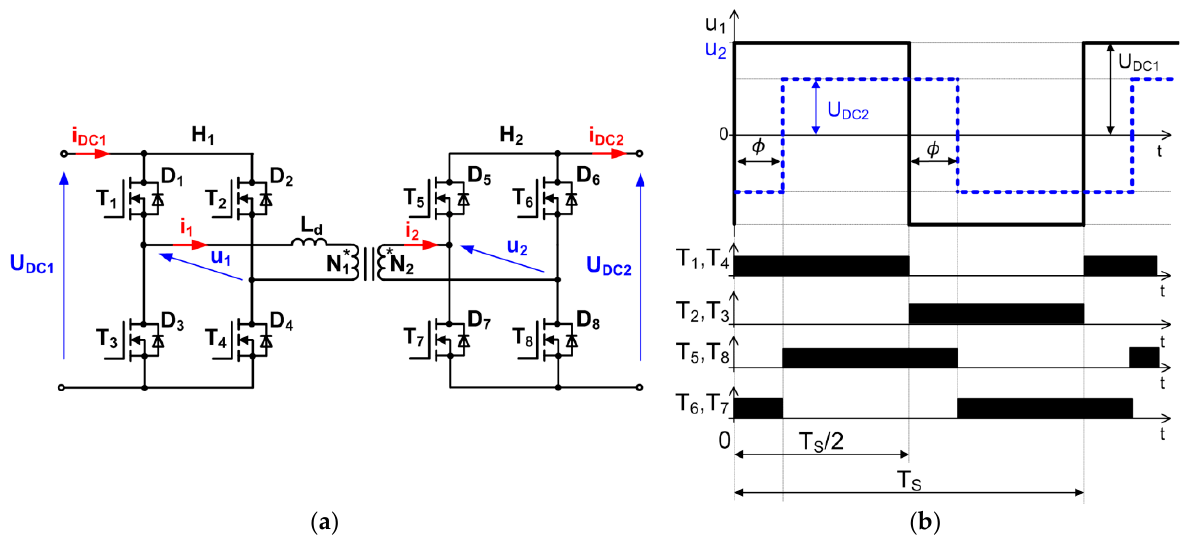
Figure 1. ( a ) Dual active bridge DC/DC converter topology; ( b ) single phase shift modulation scheme.